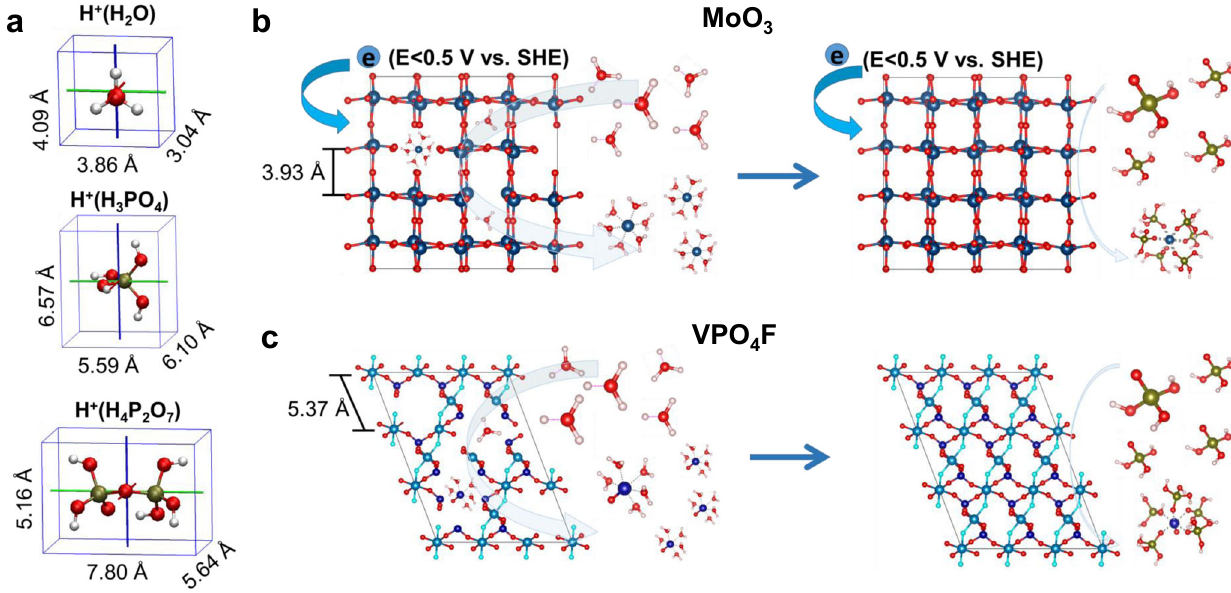
Fig. 4 | SchematicofDFT simulations.a Theionic size ofvarious solvated protonstructures. The schematic comparisons of the proton intercalation into b the reduced MoO 3 and c VPO 4 F lattice framework in the diluted 1M H 3 PO 4 (left) and PPA (right)